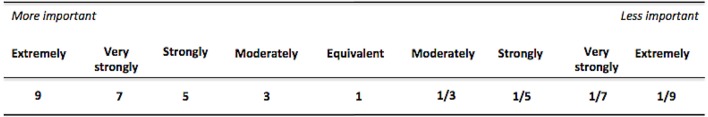
Simplified Saaty Scale used for comparing risk factors in the analytical hierarchy process.